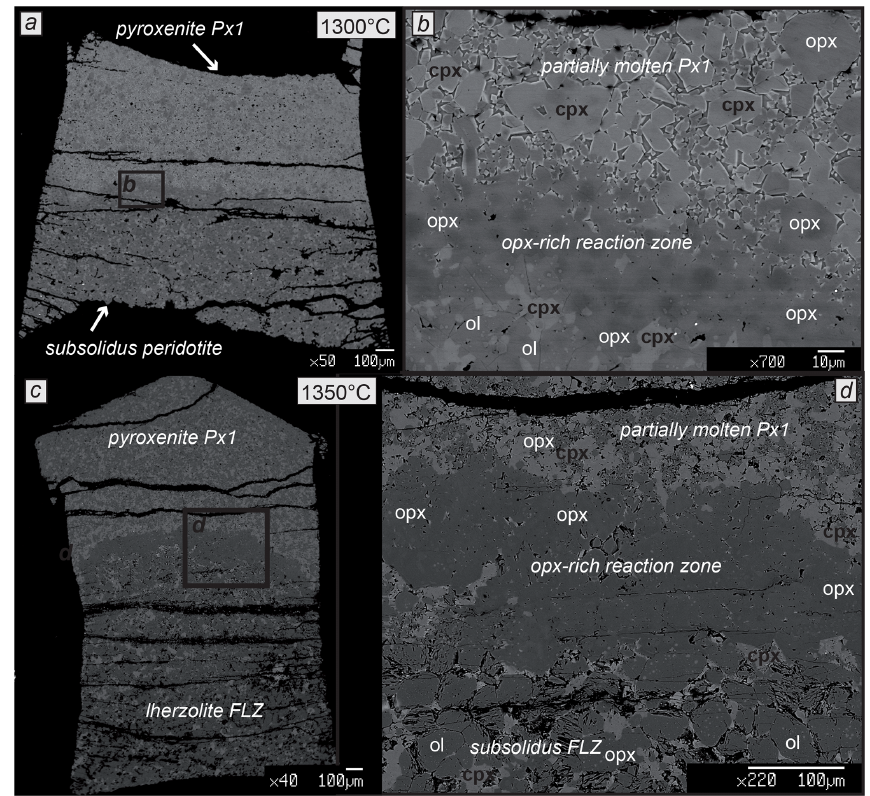
Figure 3. Back-scattered electron (BSE) images of the experimental charges after reaction runs at 2GPa, 1300 and 1350 ◦ C (a, c) . Molten pyroxenite Px1 and subsolidus lherzolite FLZ are bounded by thin orthopyroxene-rich reaction layers that are shown in the zoomed panels on the right (b, d)